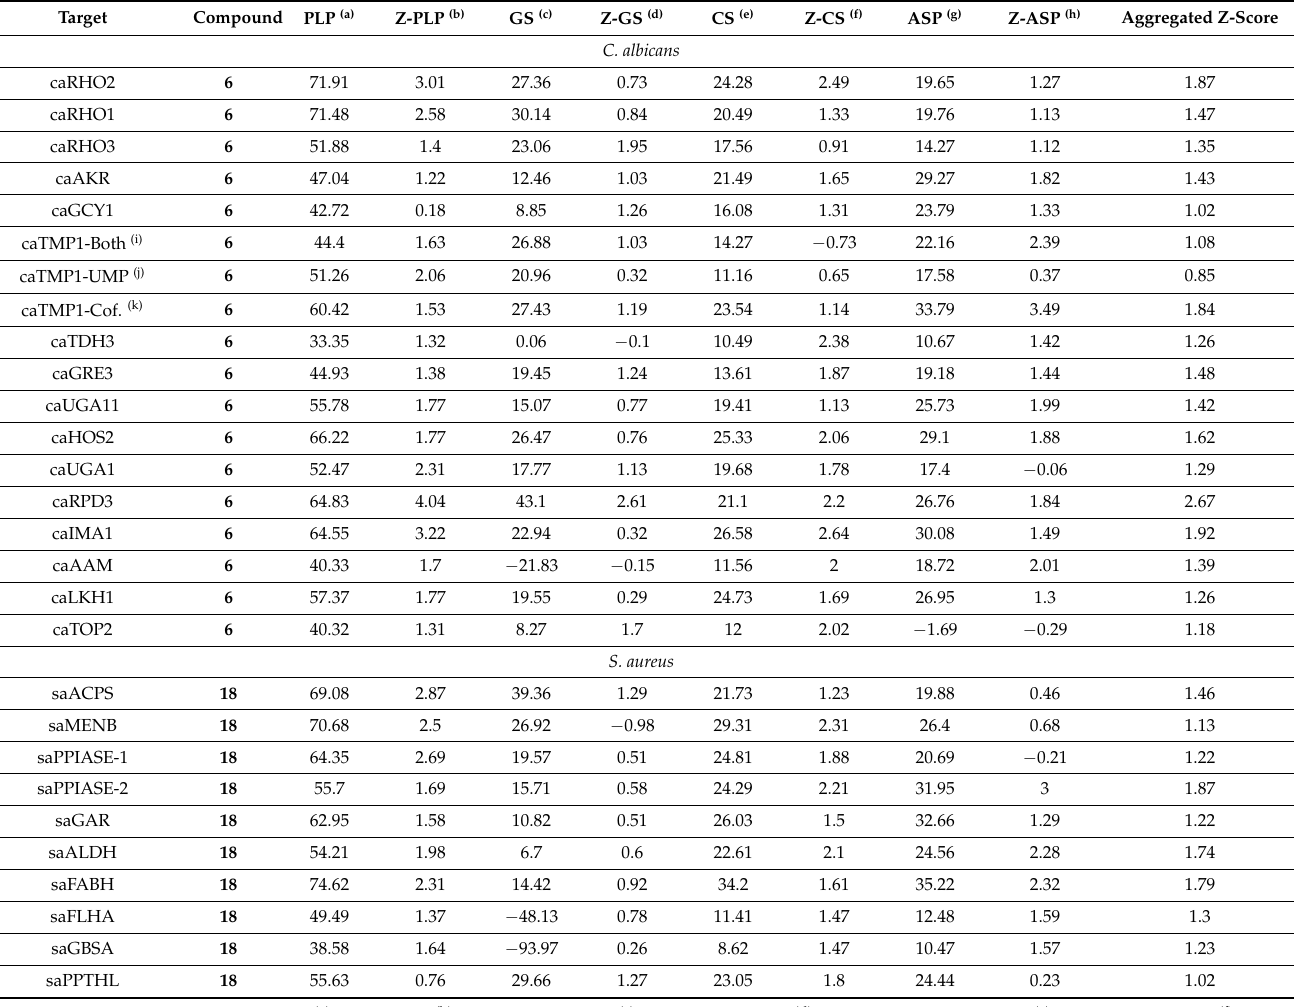
Table 10. Docking results for compounds 6 and 18 with their probable targets in C. albicans and S. aureus